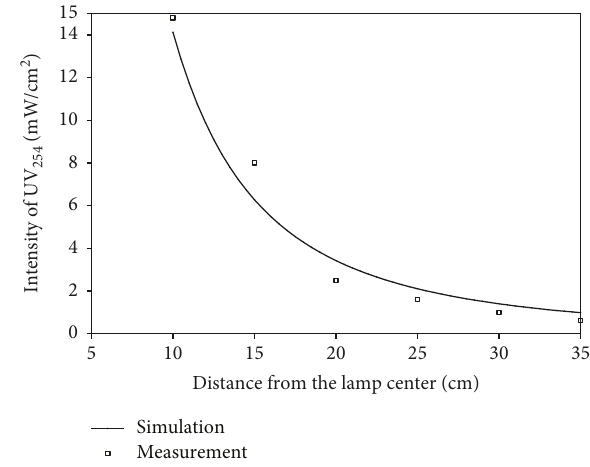
Figure 4: The experimental data and simulation data of the UV intensity with the change of